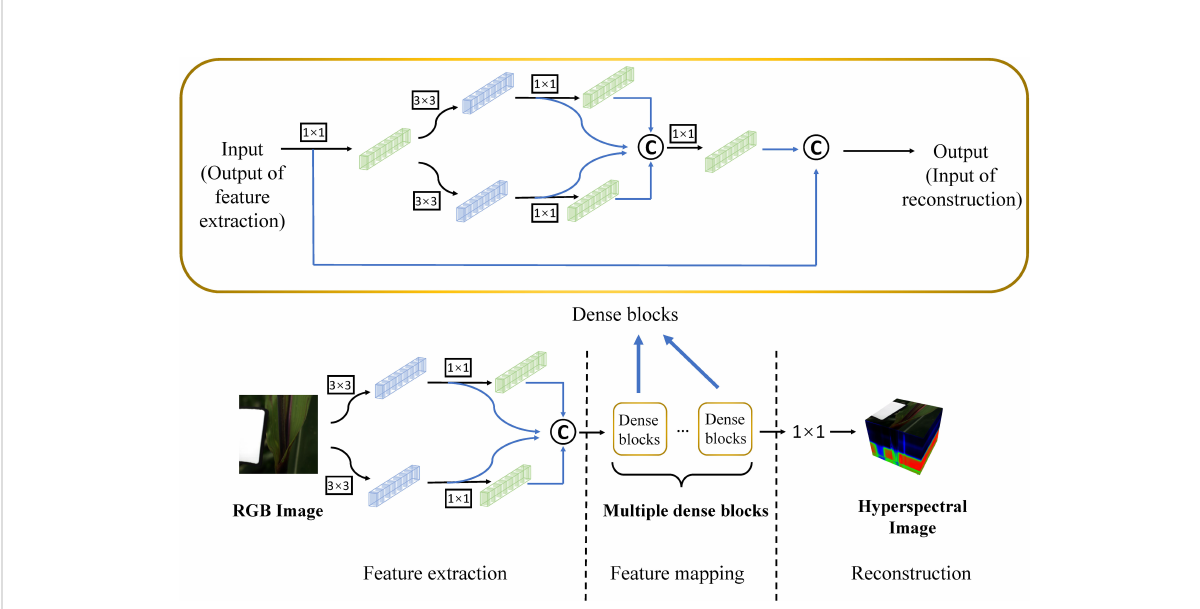
FIGURE 3 Network structure of the HSCNN+. The notation “ 1 × 1 ” and “ 3 × 3 ” denote the convolution with the kernel size of 1 × 1 and 3 × 3 respectively. The notation with rectangular box denotes the convolution is followed by ReLU activation function. The notation “ C ” with a circular box denotes the concatenation